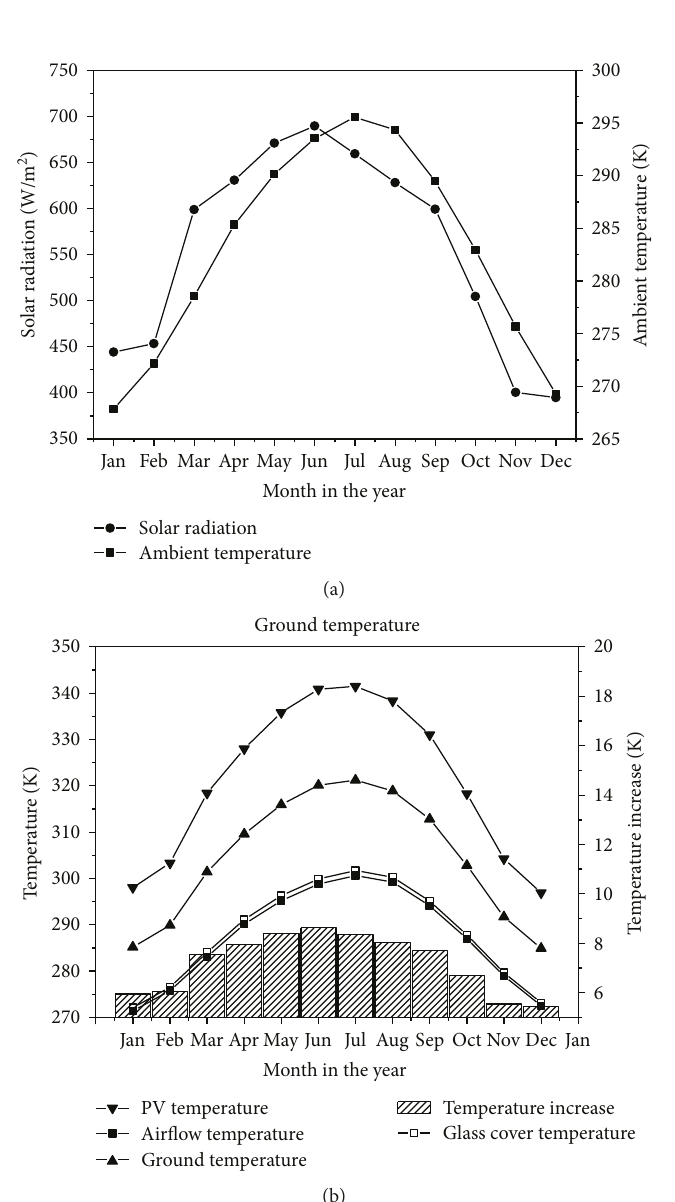
Figure 5: (a) Solar radiation and ambient temperature of the SCPVTPP. (b) Temperatures of the glass cover, air fl ow, PV module, and ground and temperature increase inside the chimney during di ff erent months in the